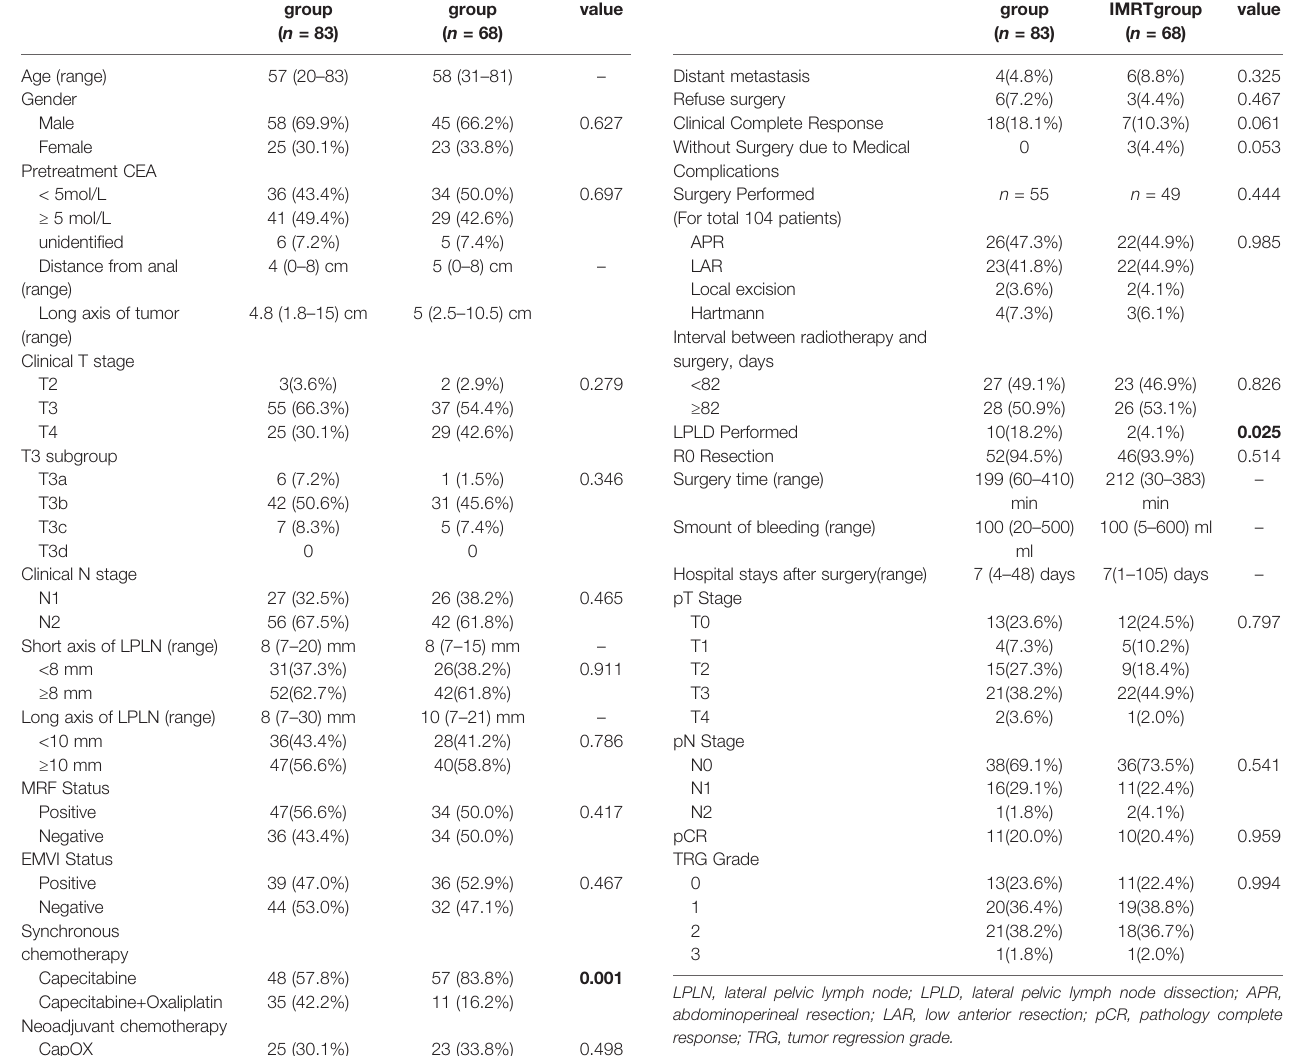
TABLE 2 | Details of short outcome between the two groups. TABLE 1 | The clinical parameters and treatments between the two groups.